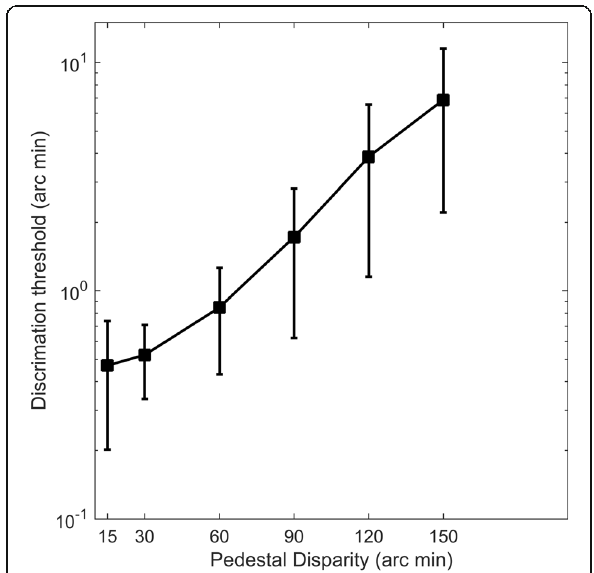
Fig. 3 Mean 75% correct depth discrimination thresholds plotted as a function of the pedestal disparity. Error bars show ± standard